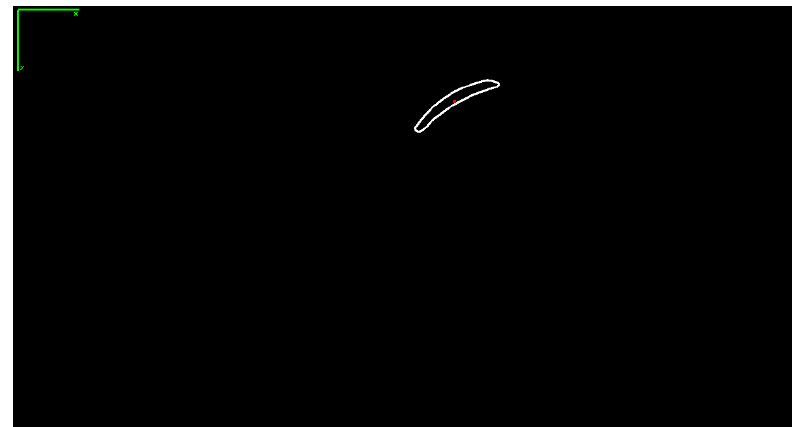
Figure 10. Contour and COG of the greatest light source.